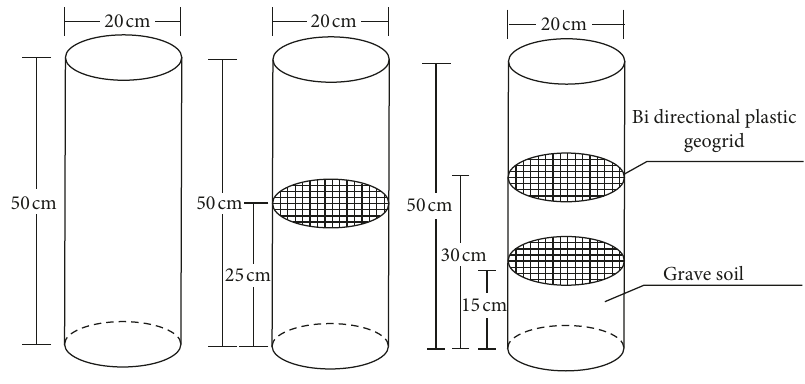
Figure 6: Geogrid placement diagram. Table 3: Calculation table of dynamic stress amplitude.